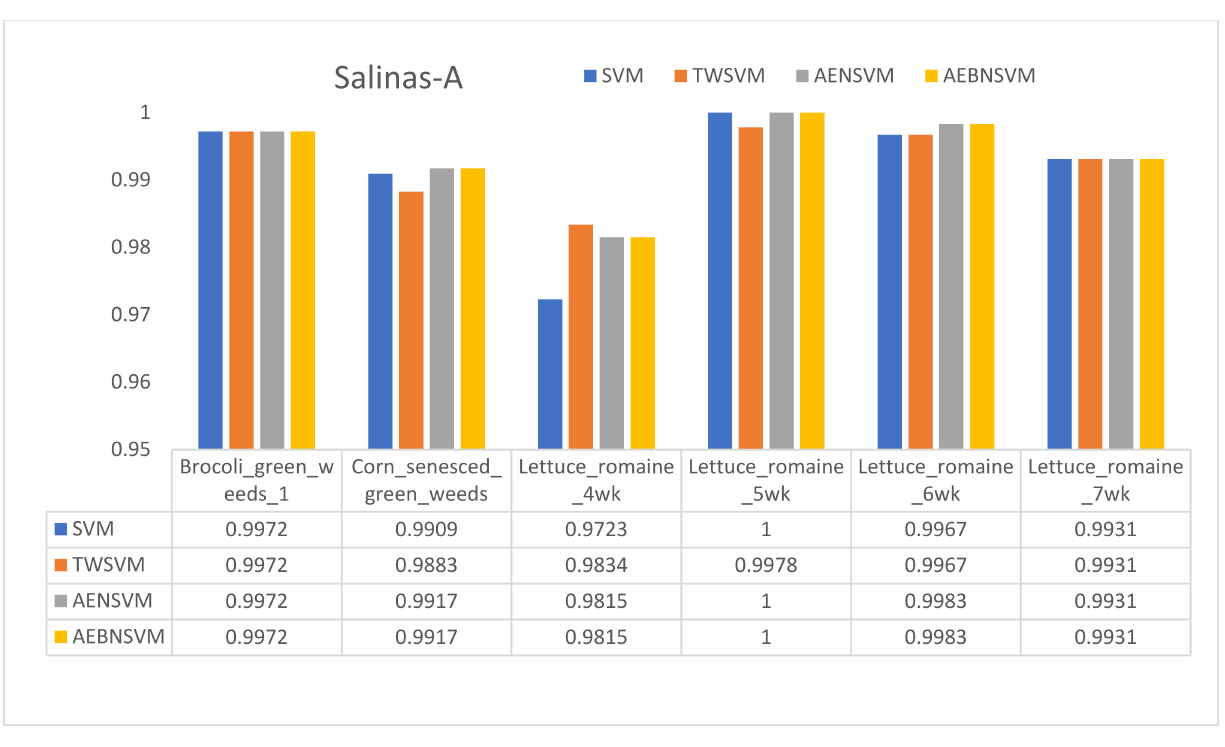
Figure 6. Classification results of different categories of Salinas-A hyperspectral images. Table 2. Classification results of Salinas-A hyperspectral images.